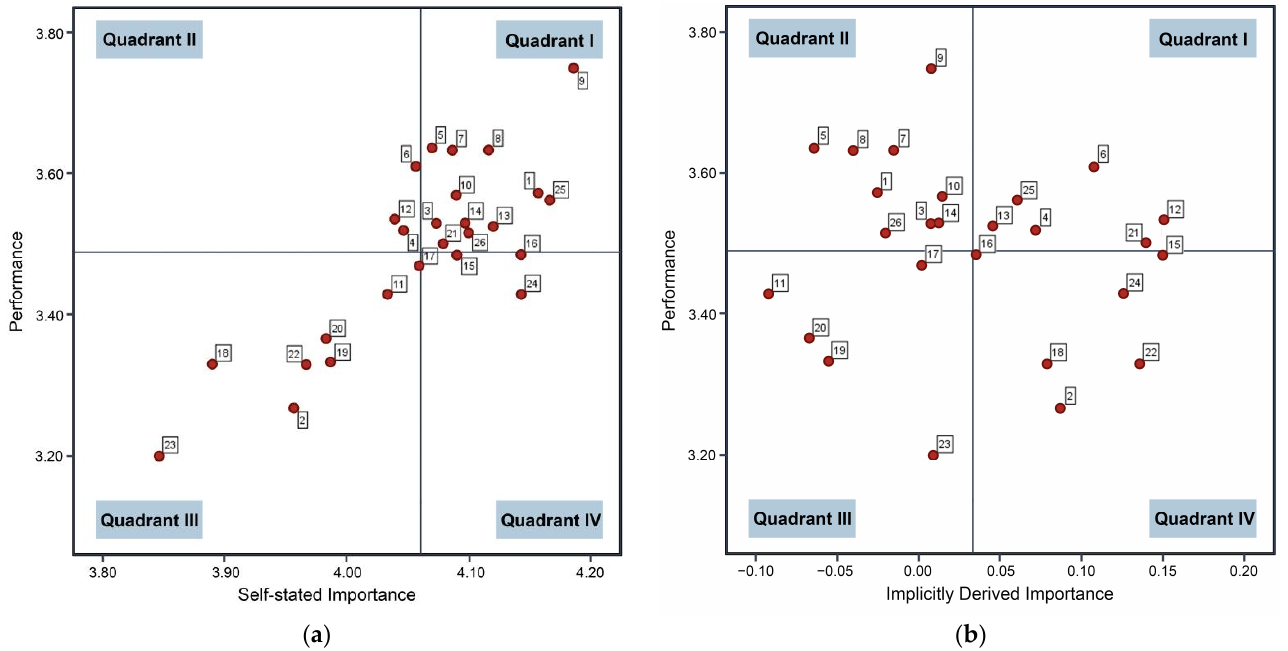
Figure 4. Analytical models for the traditional and revised IPA: ( a ) The performance–self-stated importance analysis model; ( b ) The performance–implicitly derived importance analysis model.